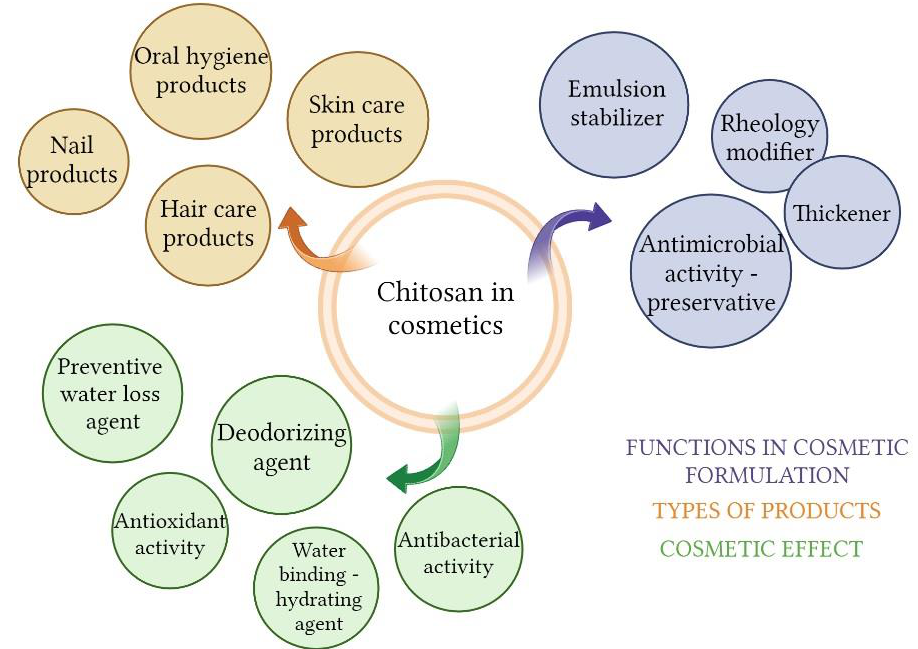
Figure 5. Chitosan in cosmetics (Created with BioRender.com, accessed on 9 February 2023). Table 1. Minimal inhibitory concentration of chitosan for selected bacterial strains (including acne- related bacteria)